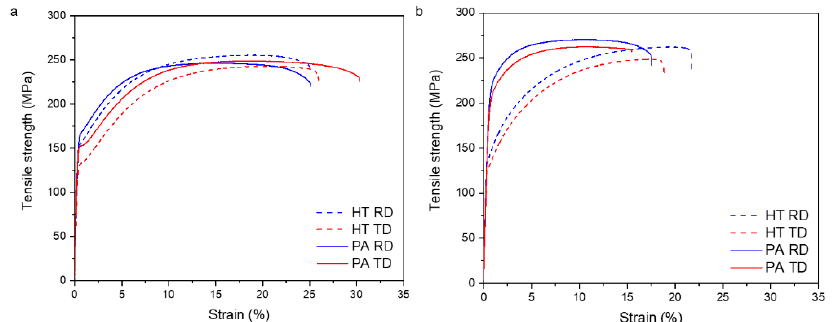
Table 3. Tensile properties of homogenized (HT) and peak-aged (PA) ZAXM2100 and ZAXM4100 alloy sheets along RD and TD. The numbers in parentheses indicate standard deviations of the re- sults.